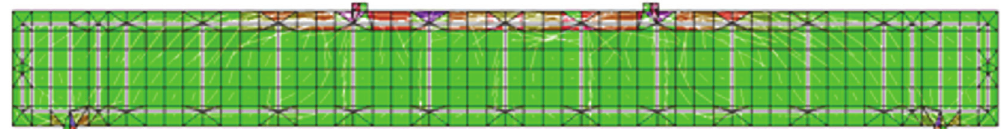
Figure 12: Typical stress flow at flexural failure modes of beams B1–B6 (VecTor2 analysis).